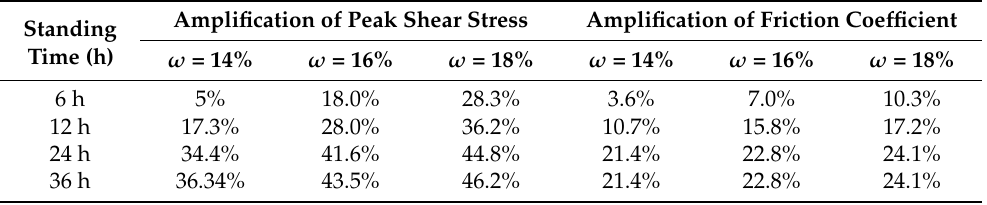
Table 4. Amplification of the peak shear stress and friction coefficient of the pipe–soil interface with different standing